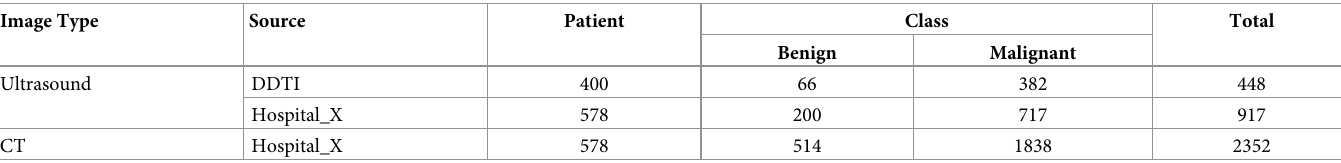
Table 1. Data sets